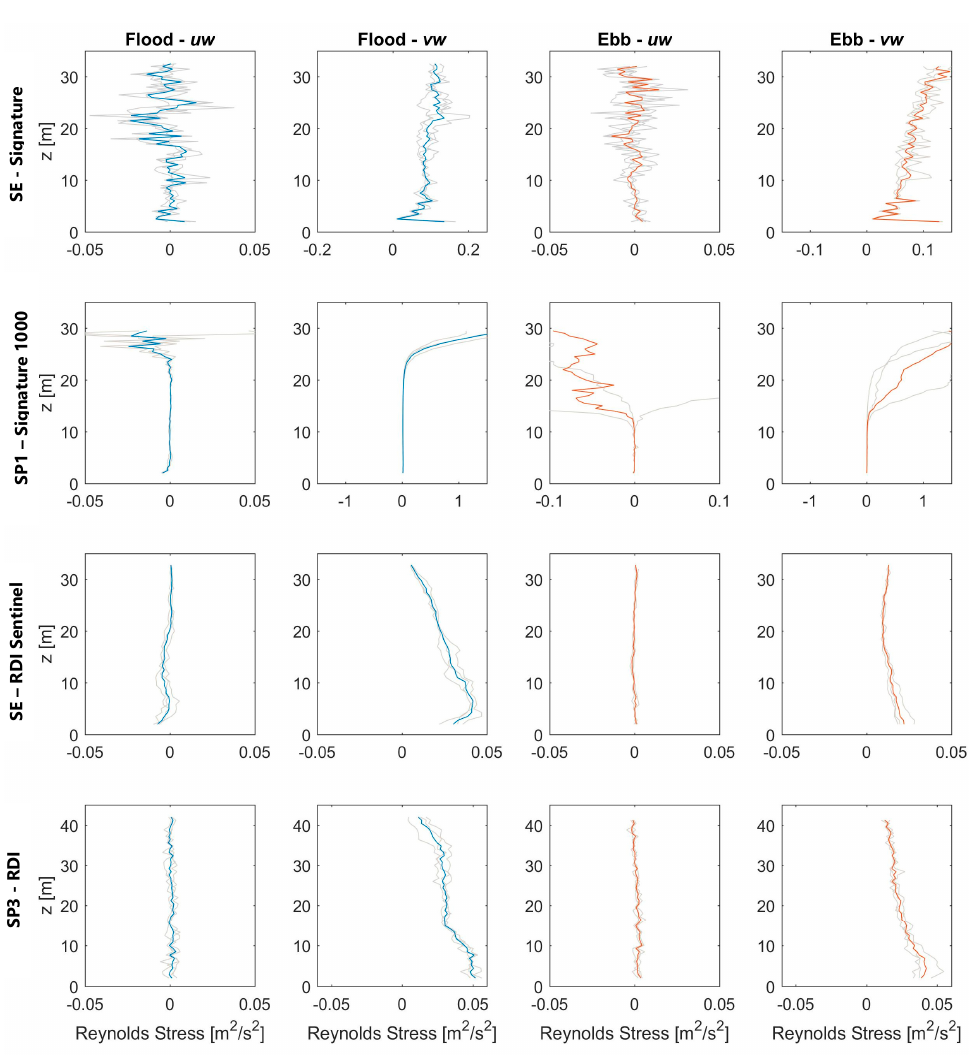
Figure 8. Reynolds stresses depth profiles for streamwise uw and transverse vw velocity components, where the flood tide is shown in blue and the ebb tide in red.